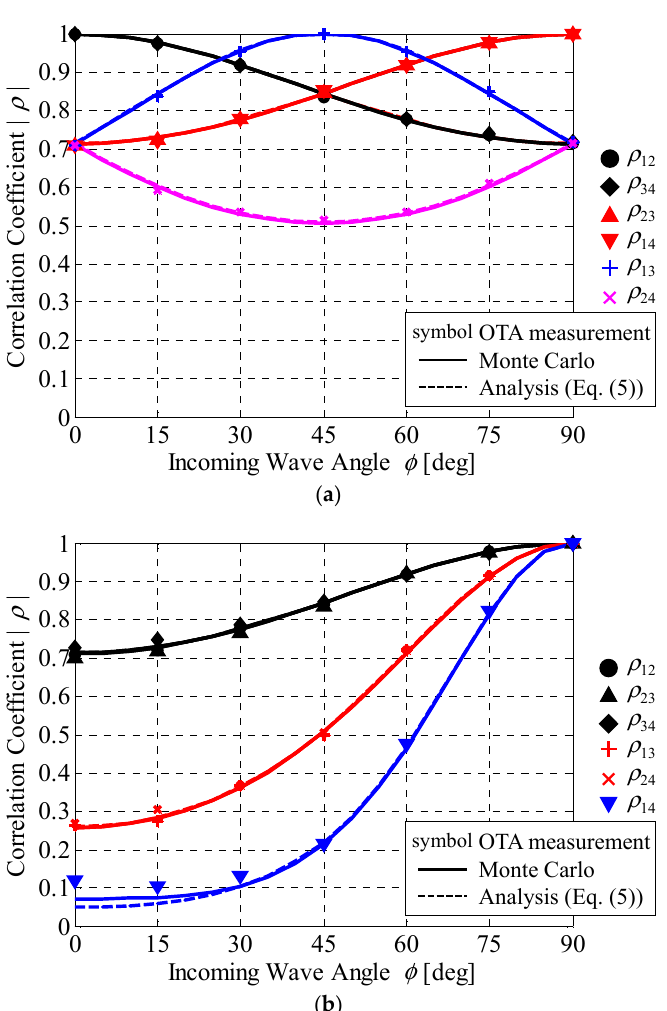
Figure 15. Characteristics of the BS correlation as a function of the incoming wave angle: ( a ) circular array; ( b ) linear array.